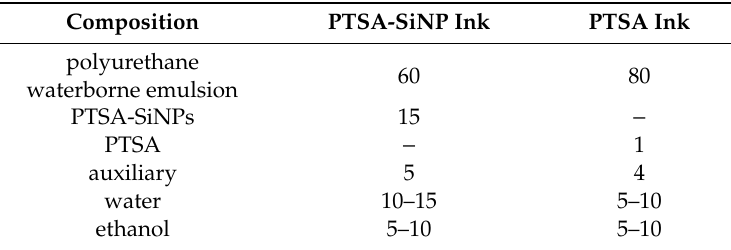
Table 1. Formula of water-based anti-counterfeit ink components